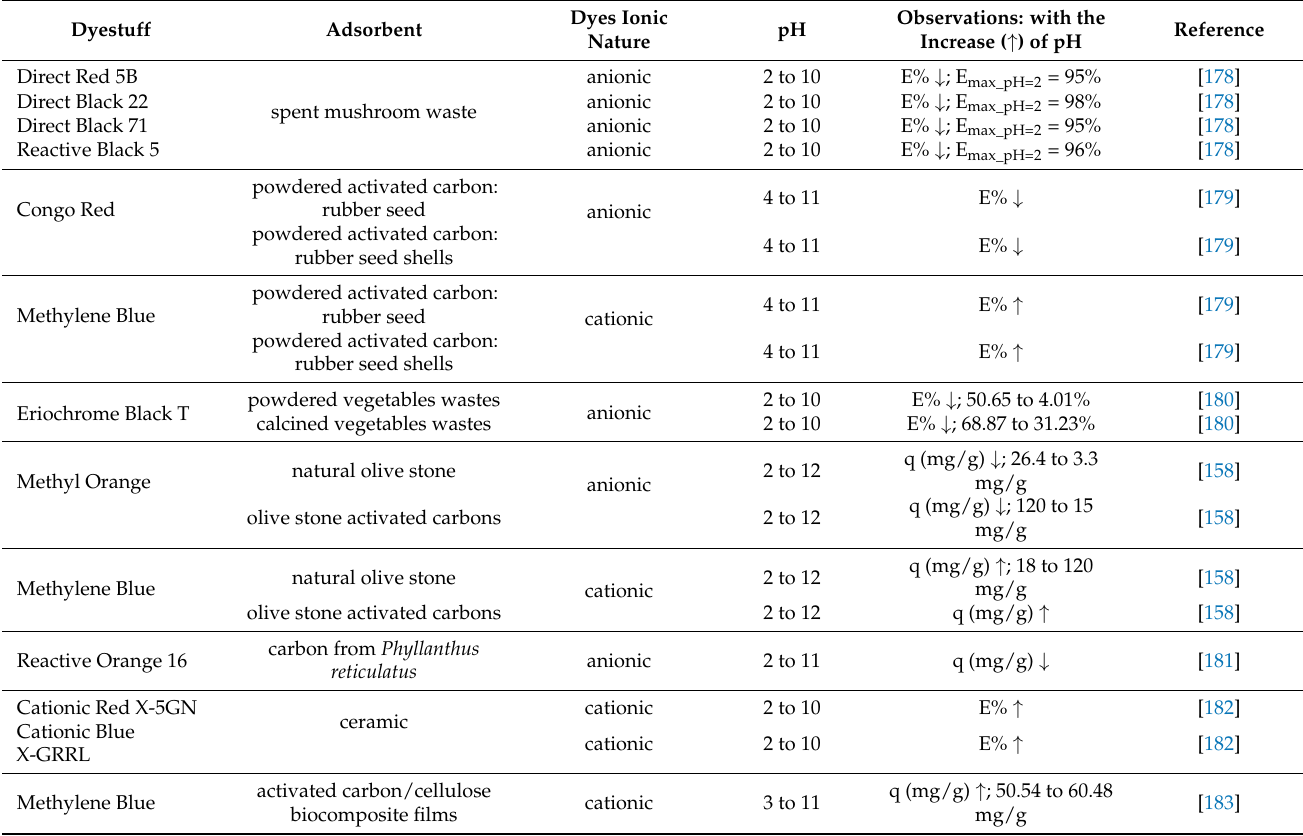
Table 2. Results of various research regarding the effect of initial solution pH, where E is the efficiency of the adsorption process and E max is the highest efficiency calculated in the specific article at a given condition.